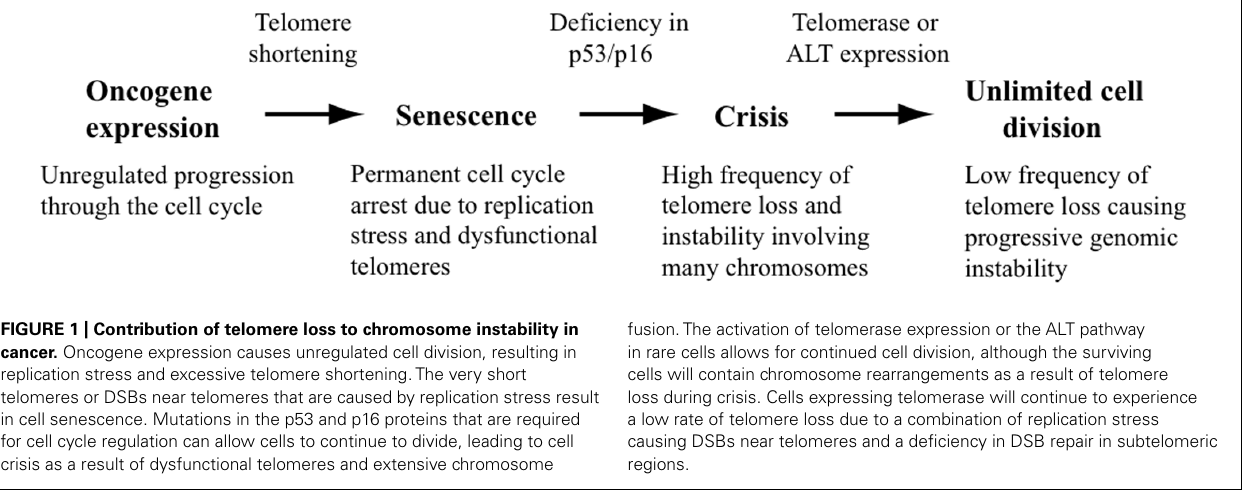
fusion.The activation of telomerase expression or the ALT pathway in rare cells allows for continued cell division, although the surviving cells will contain chromosome rearrangements as a result of telomere loss during crisis. Cells expressing telomerase will continue to experience a low rate of telomere loss due to a combination of replication stress causing DSBs near telomeres and a deficiency in DSB repair in subtelomeric